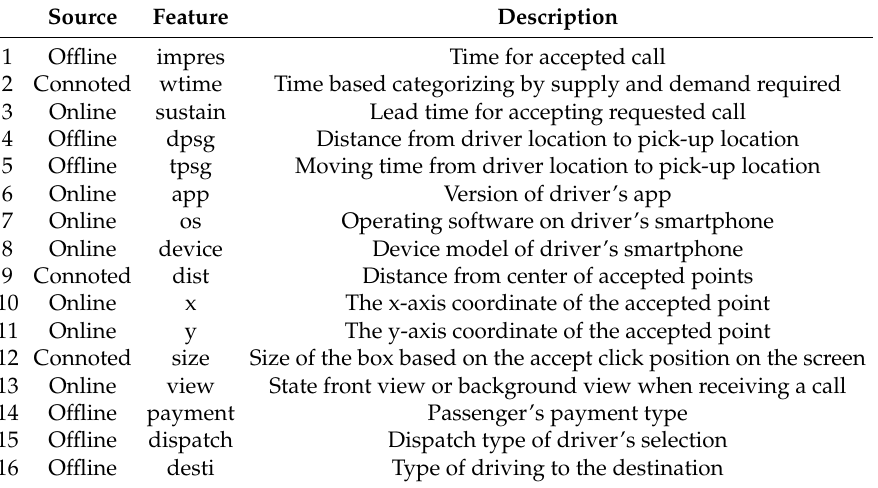
Table 3. Feature